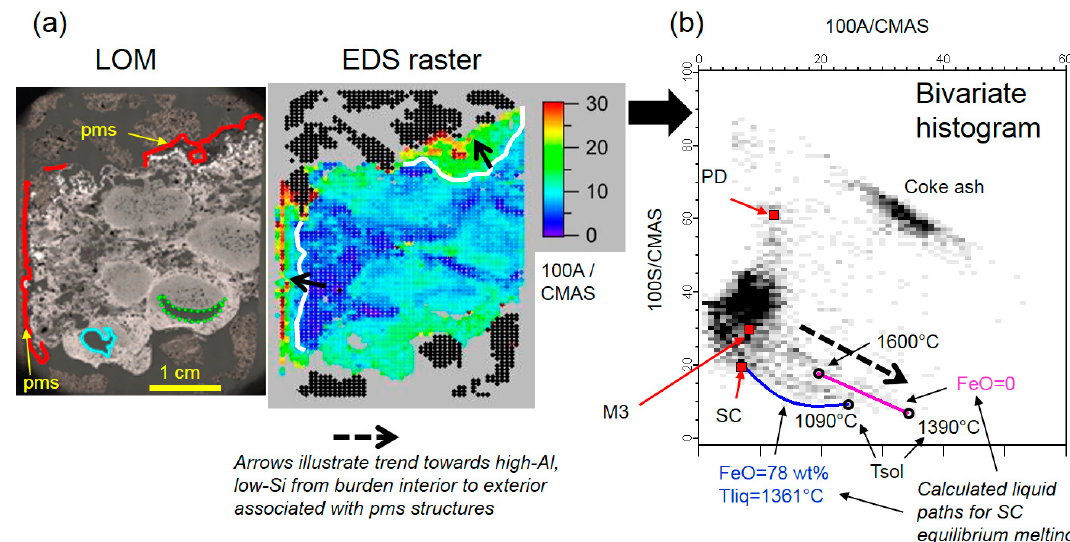
Figure 6. ( a ) spatial variations in local bulk chemistry (0.5 mm resolution) associated with partial metal segregation (PMS) structures; ( b ) bivariate histogram of EDS area raster analyses from ( a )—greyscale indicates density of analyses: black = high density, white = zero (no analyses). Sinter (SC), pellet (PD), M3: see Table 1.